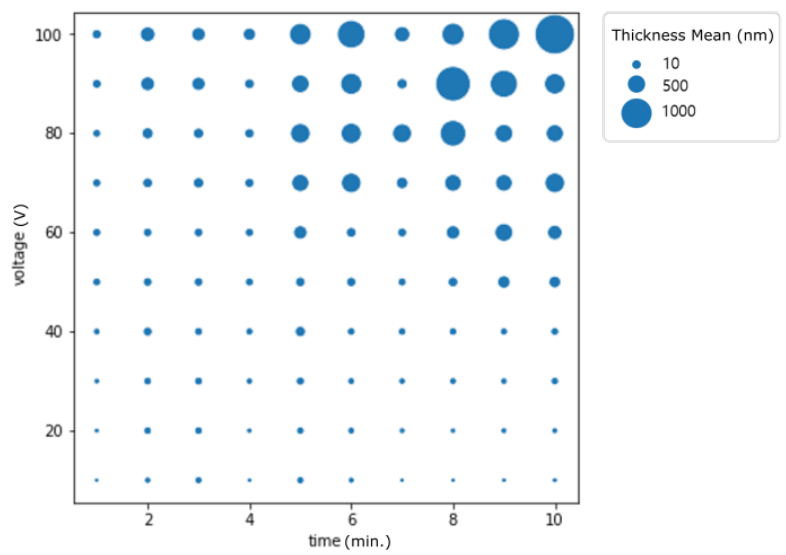
Figure 2. Mean thickness change by voltage and time